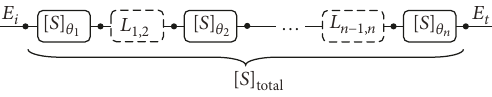
Figure 3: A multilayered network schematic.